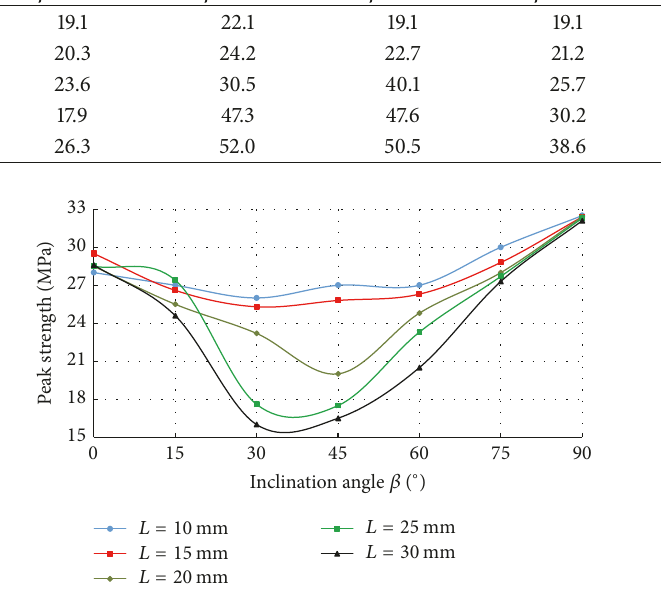
Figure 7: The peak strengths of model containing single flaw.